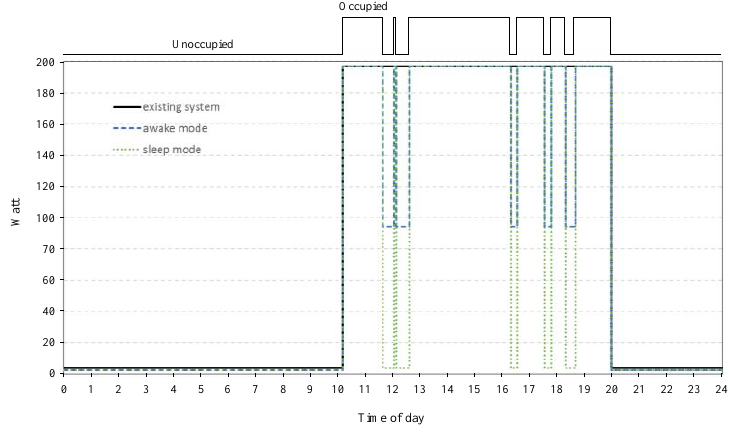
Figure 16. Occupant A, plug load (Wednesday).